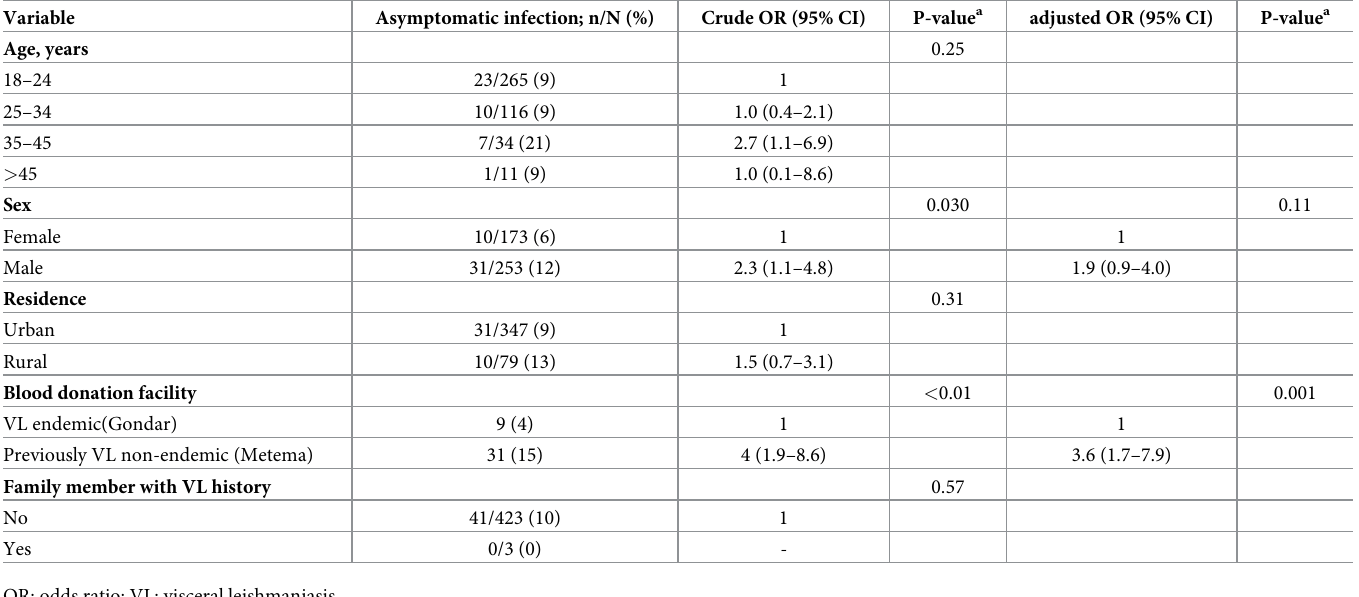
Table 3. Factors associated with asymptomatic Leishmania infection among blood donors at two sites in Northwest Ethiopia,